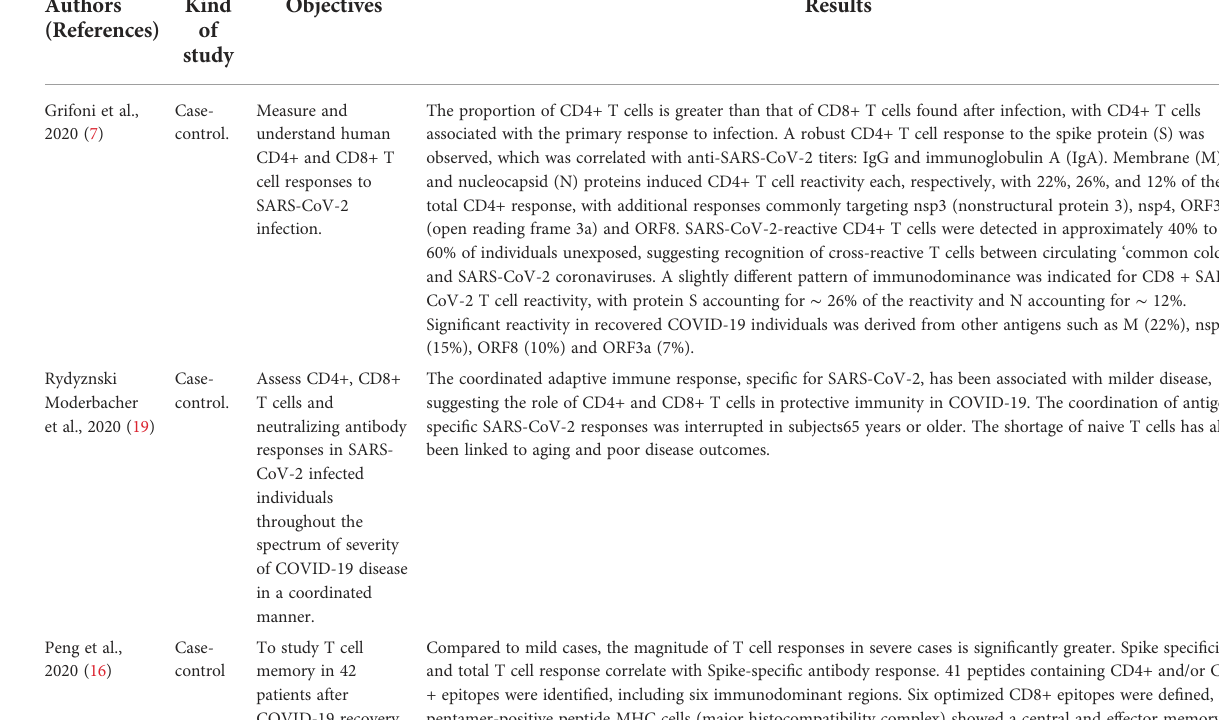
TABLE 1 Characteristics of the studies included in the systematic